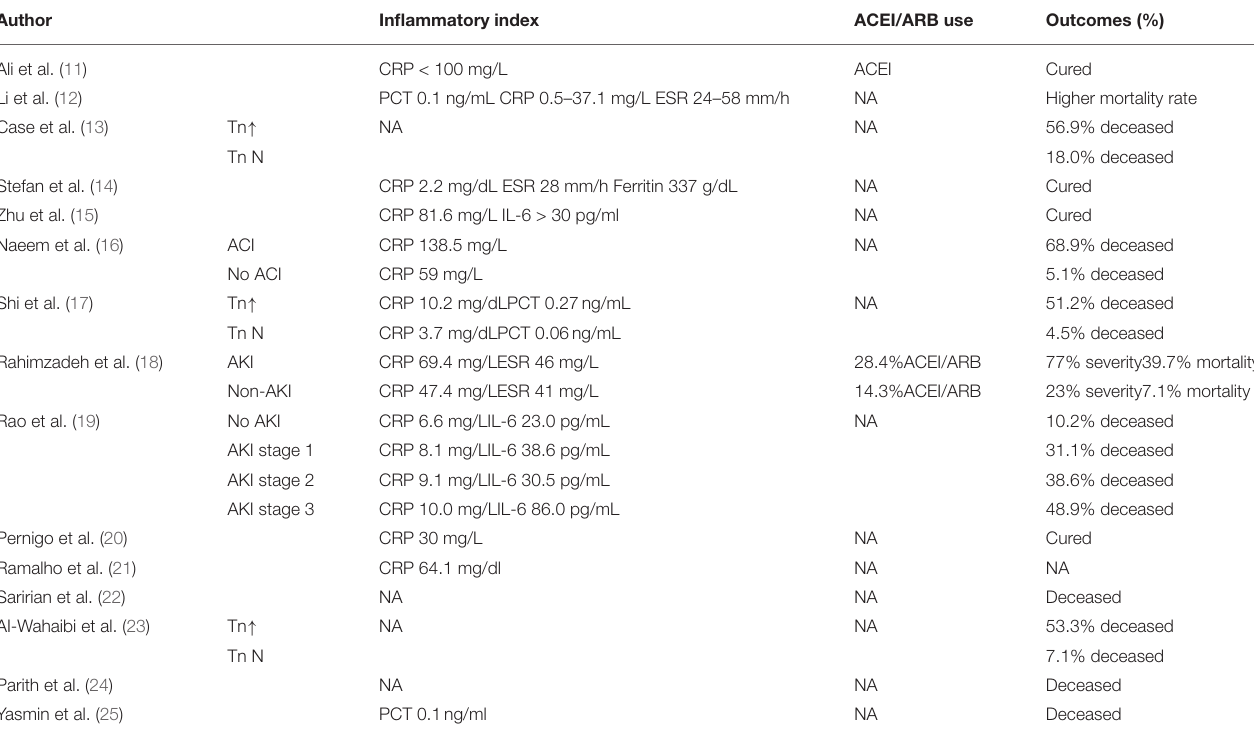
TABLE 4 | Inflammatory index, ACEI/ARB use and the outcomes in COVID-19 patients with cardiac and renal complications. Author